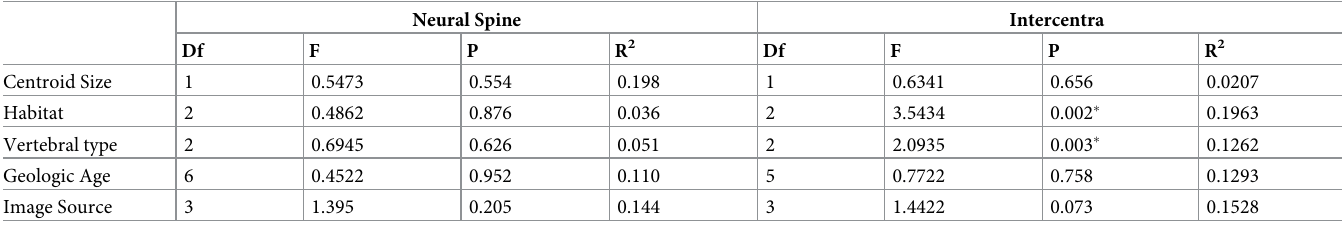
Table 3. Phylogenetic-ANOVA results.